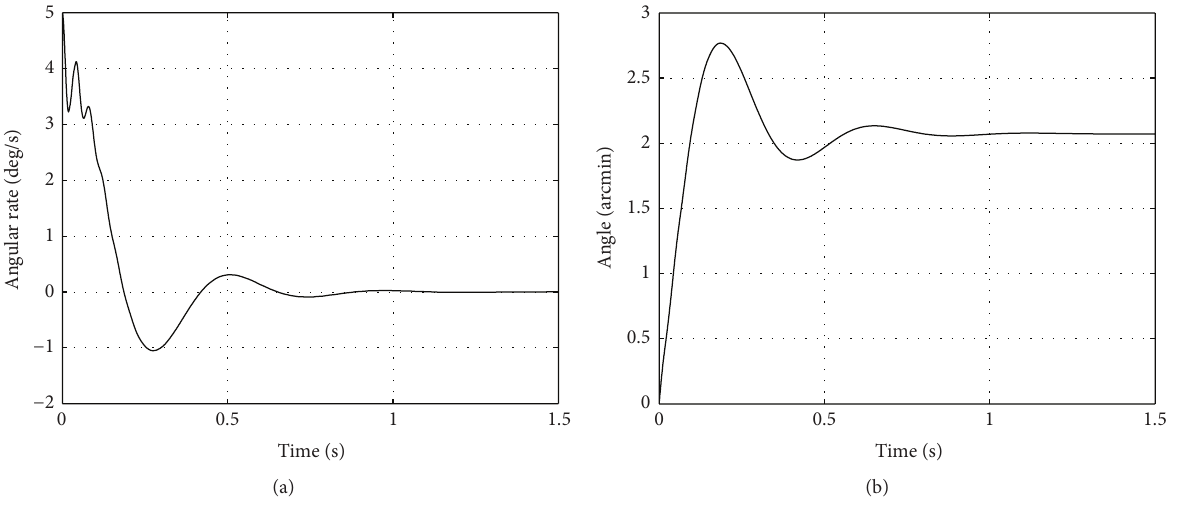
Figure 8: Results of simulation of the platform motion in the mode of precision stabilization: (a) is transient of the given angular rate; (b) is error of the angular position